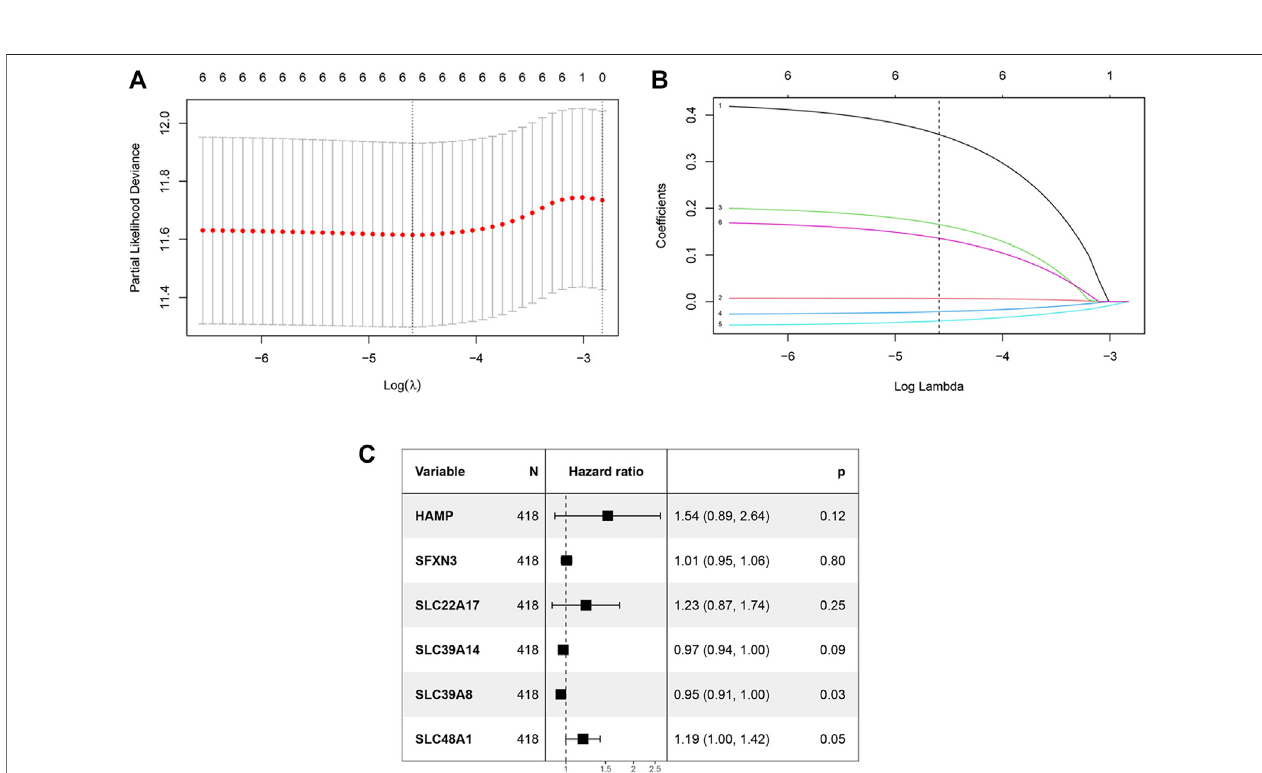
FIGURE 2 | Construction of the iron metabolism model. (A) 1000 bootstrap replicates by lasso Cox regression analysis for variable selection. (B) LASSO coef fi cients of iron metabolism genes. Each curve represents a metabolic gene. (C) Multivariate Cox regression analysis.